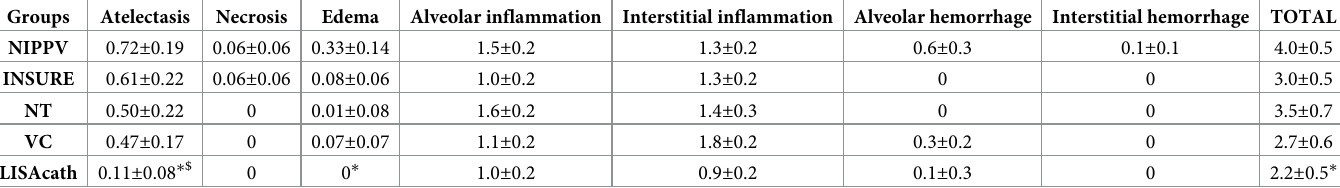
Table 3. Total lung injury